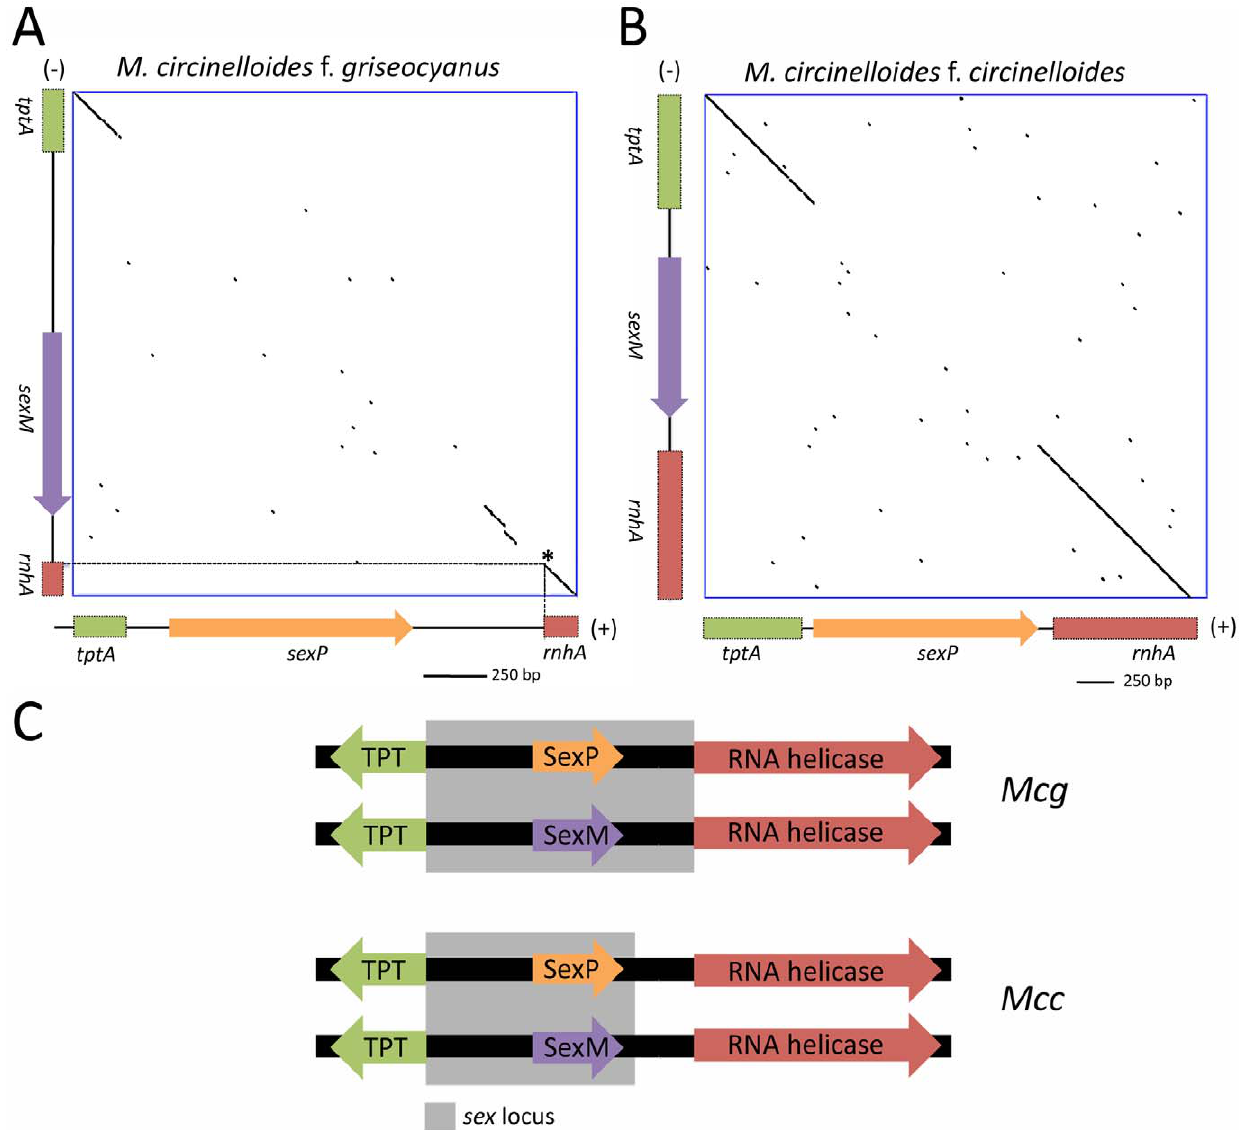
Figure 9. Defining the ( + ) and ( 2 ) sex locus alleles in M.circinelloides f. griseocyanus and Mucorcircinelloides f. circinelloides . (A) Dot plot comparison of the sex locus alleles of the ( + ) and ( 2 ) strains of Mcg and Mcc show the sex specific regions with conserved flanking gene regions. The tptA and rnhA genes encoding the TPT and RNA helicase, respectively, are highly conserved between the ( + ) and ( 2 ) alleles; however, the sex genes encoding HMG domain proteins are divergent in sequence. Interestingly, the promoters for the TPT and RNA helicase genes are part of the sex locus in Mcg (A) but only the TPT promoter is part of the sex locus in Mcc (B). The regions of the tptA and rnhA genes sequenced are depicted (5 9 regions of the genes). sex loci of ATCC1207a ( + ) and ATCC1207b were sequenced for Mcg and those of NRRL3614( 2 ) and NRRL3615 ( + ) were sequenced for Mcc . Dotted lines indicate the start of the rnhA gene. Asterisk indicates the start of the RNA helicase gene. (C) The promoters for the TPT and RNA helicase genes are part of the sex locus in Mcg but only the TPT promoter is part of the sex locus in Mcc .